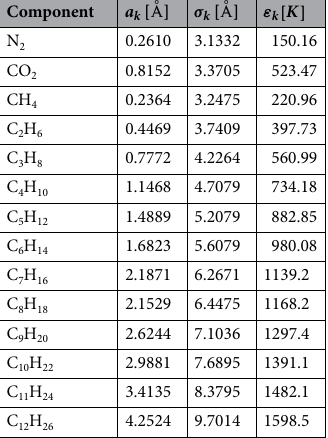
Table 6. Adjusted Kihara parameters of nitrogen, carbon dioxide, and light to semi-heavy normal alkanes.